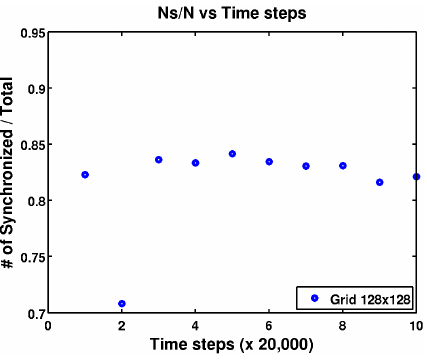
Figure 9. Influence of the non-local coupling coefficient parameter, κ , on the ratio of the number of synchronized oscillators to the total number of oscillators for both the 128 × 128 and the 1024 × 1024 grids without